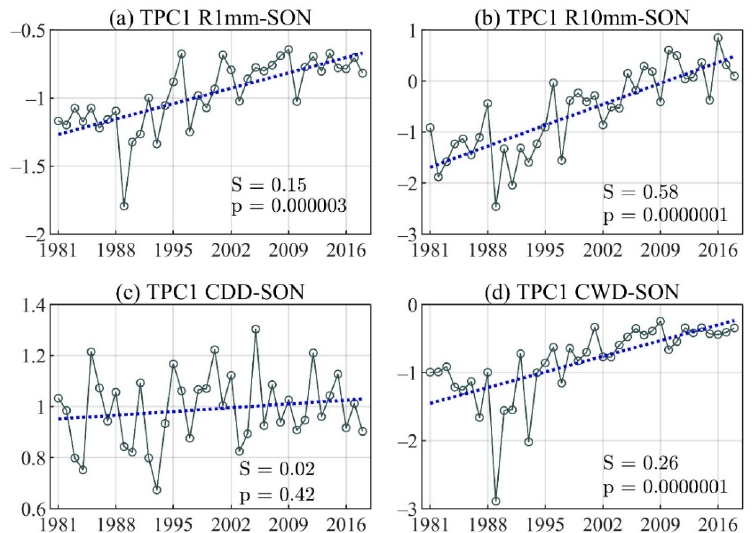
Figure A5. The linear trend of the principal component time series for the first TEOF mode of (a) Number of wet days (R1mm), ( b ) Number of days with precipitations above R10mm (R10mm), ( c ) Consecutive dry days (CDD), and ( d ) Consecutive wet days (CWD) during the June–August (JJA) season.